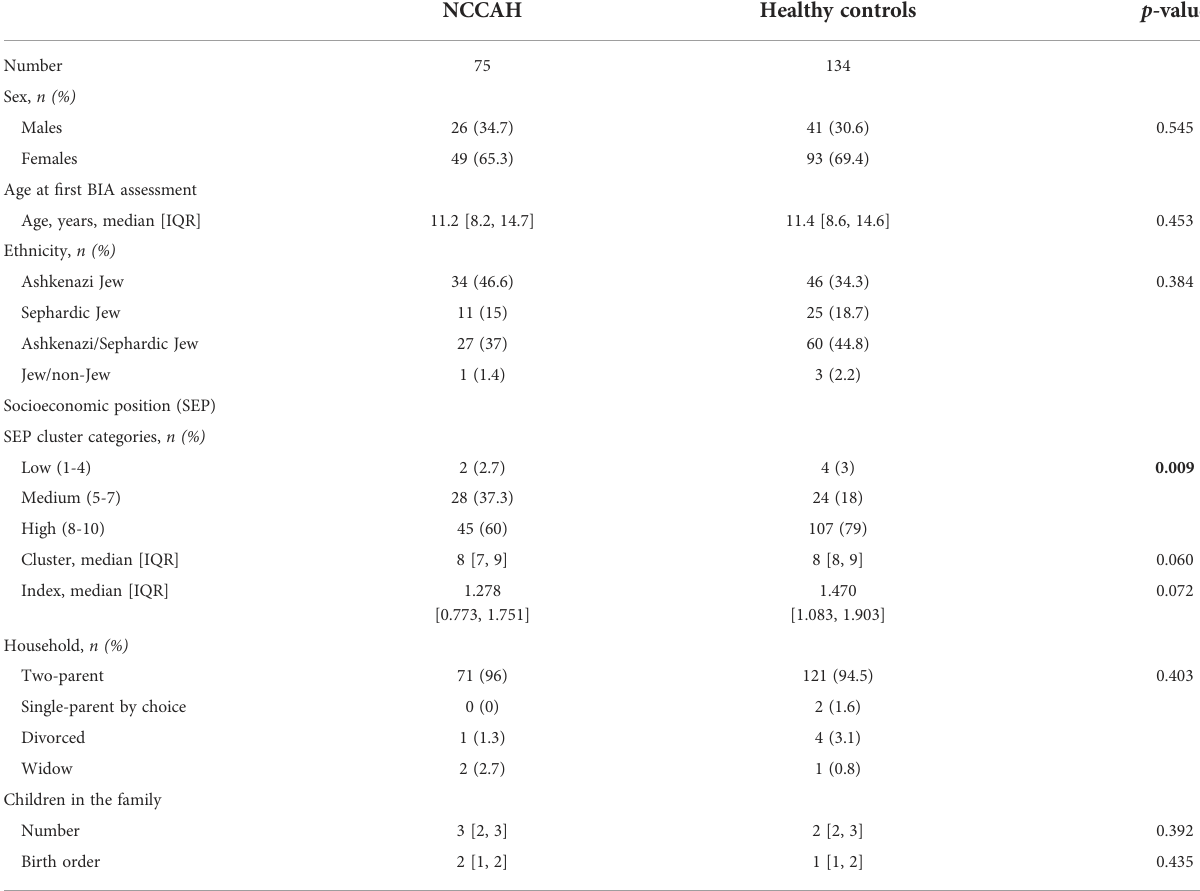
TABLE 1 Sociodemographic characteristics of the NCCAH group and their healthy